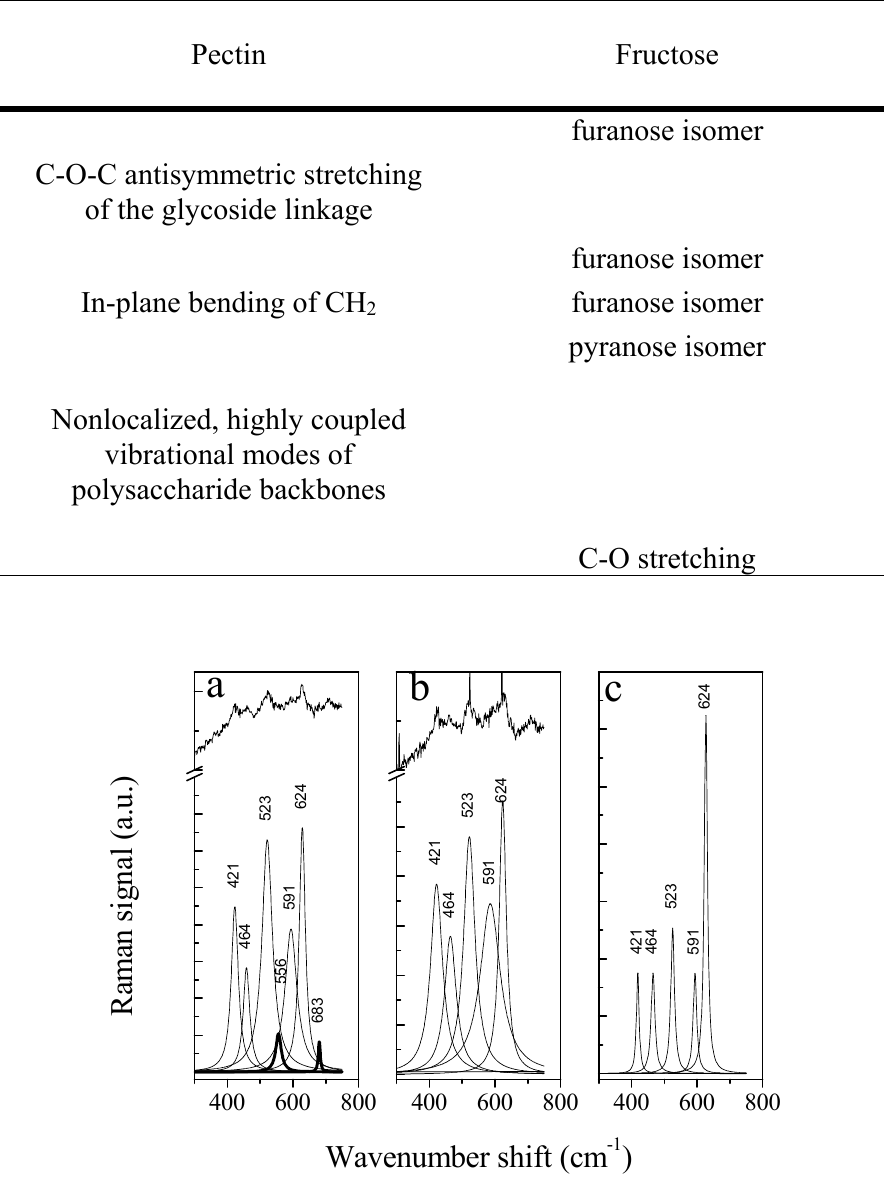
Figure 3 . Comparison of Raman spectra in the 300-750 cm -1 range of : ( a ) apple juice of type A (before depectisation) , ( b ) apple juice of type B (after depectinisation) and ( c ) fructose (Ref.